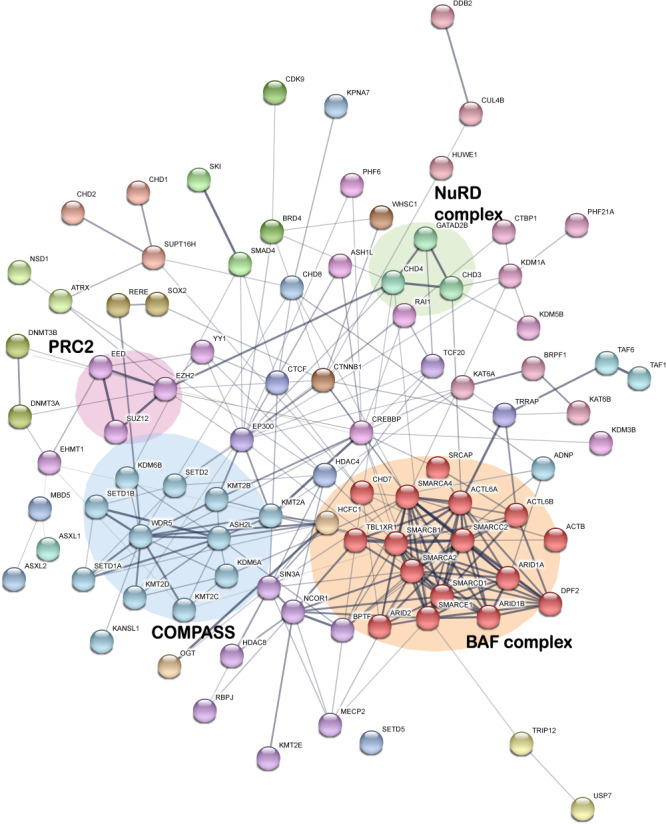
Simplified protein–protein interaction network of compiled chromatinopathy genes generated by StringDB (version 11.0, MCL clustering) analysis of chromatinopathy genes. For clarity, only proteins with interactions are shown. Connecting lines showing medium- and high-confidence experimental interactions (confidence > 0.400) with line thickness indicates the strength of data support.